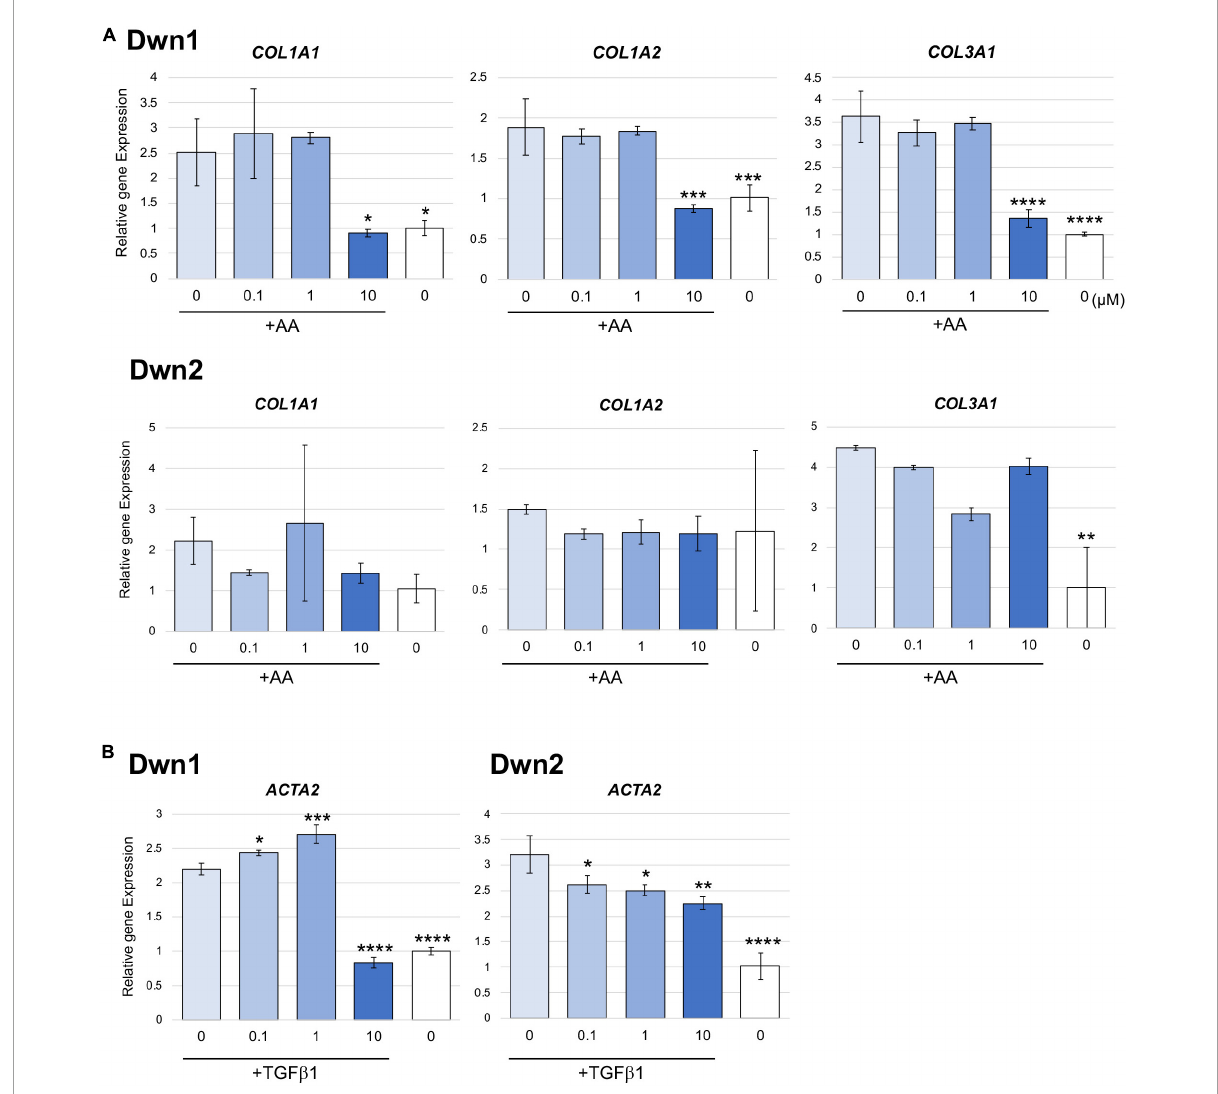
FIGURE2 Gene expression for Dwn1 and Dwn2 at various concentrations. (A) Figure represents the gene expression of collagen type I ( COL1A1, COL1A2 ) and collagen type III ( COL3A1 ) on HDFa treated with various dose of Dwn1 or Dwn2 supplemented with AA ( N = 3). (B) Figure represents a-SMA ( ACTA2 ) gene expression on human dermal fibroblasts (HDFa) with various dose of Dwn1 or Dwn2 under TGFb1 and AA stimulation ( N = 3). The graphs represent the average ± STD. The gene expression values analysis consisted of one-way ANOVA and Dunnet’s Test (* P < 0.05, ** P < 0.01, *** P < 0.001, **** P <